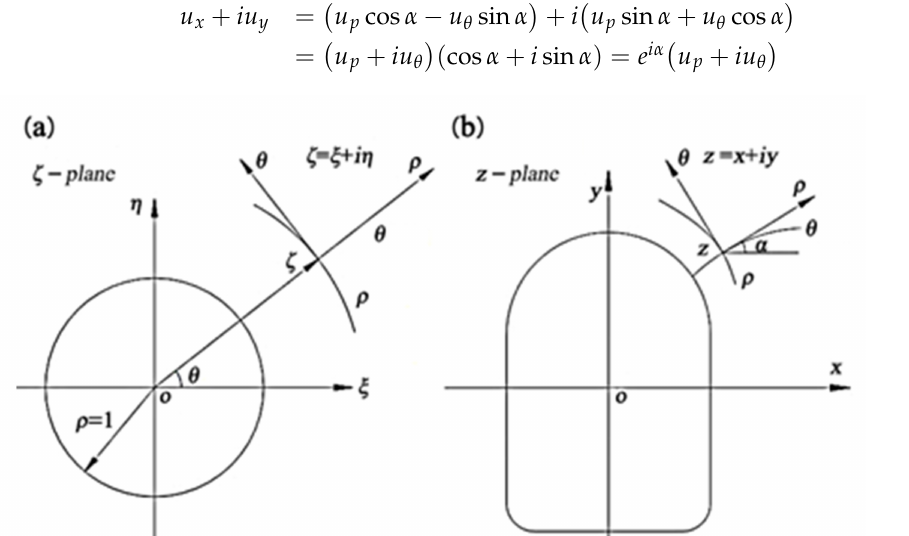
Figure 5. ( a ) Polar coordinates system in ζ plane; ( b ) orthogonal curvilinear coordinates in z